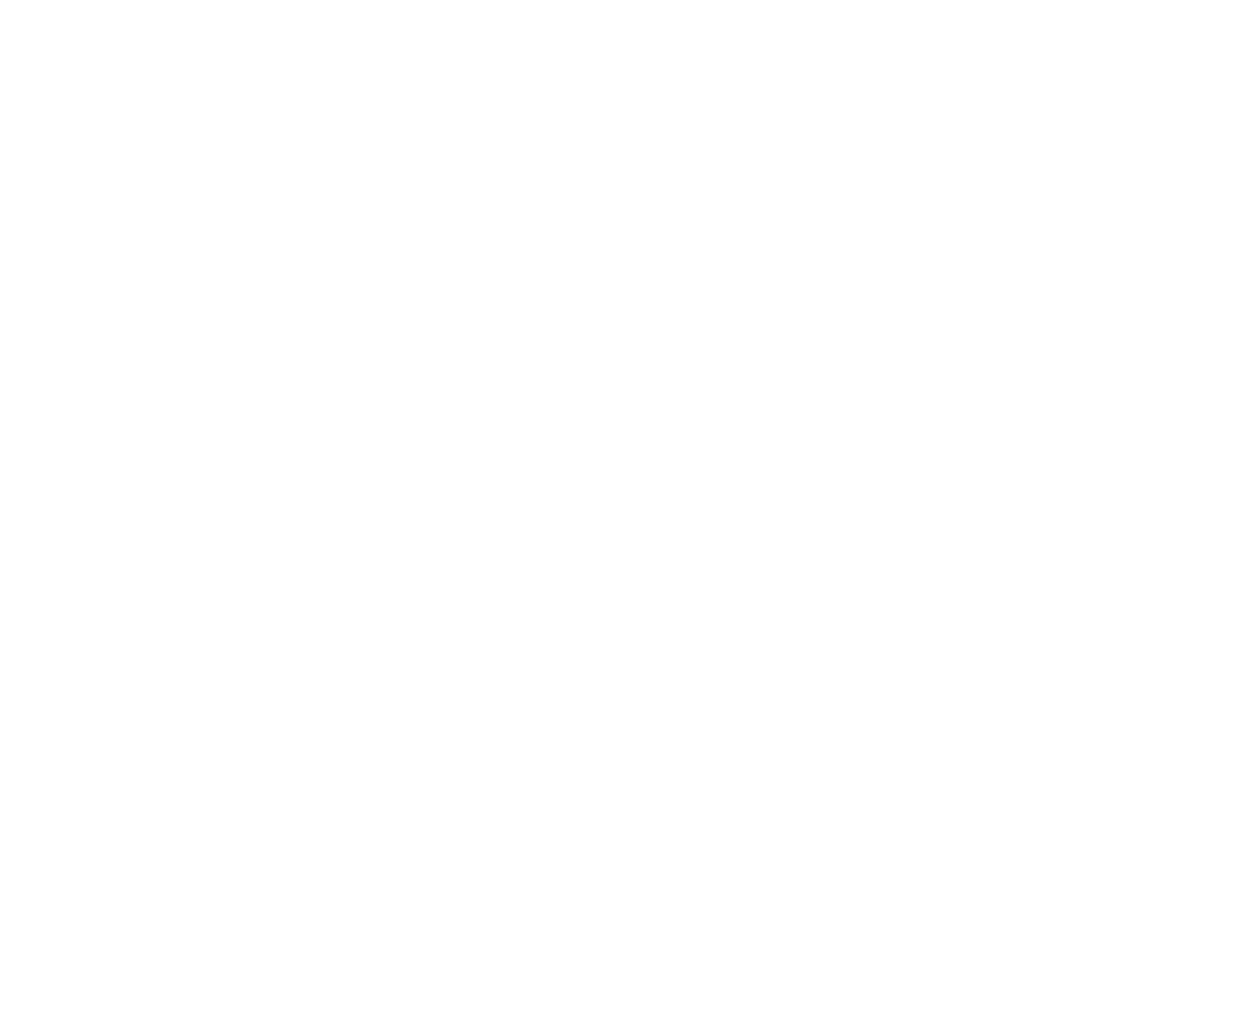
Frontiers in Communication |